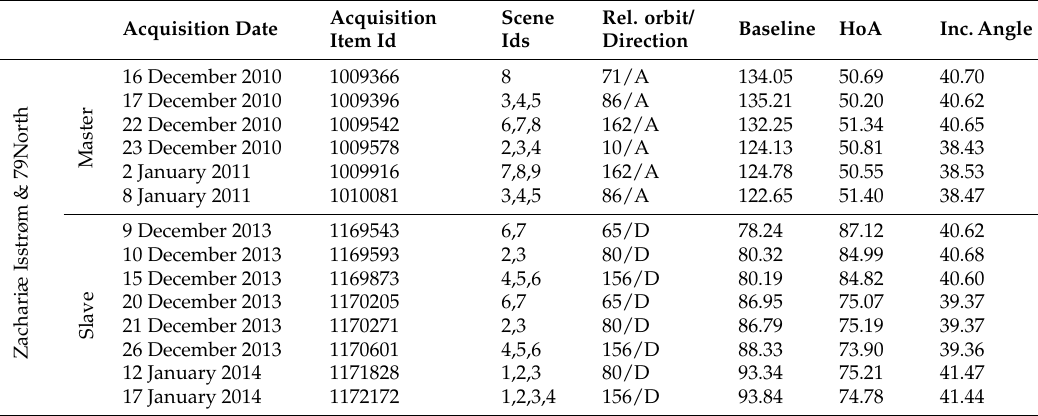
Table 1. Specifications for the TanDEM-X RawDEMs processed for Zachariæ Isstrøm and 79North. All bistatic scenes were acquired for the initial generation of the TDM global DEM and therefore have optimal baselines for DEM generation. A, ascending orbit direction; D, descending orbit